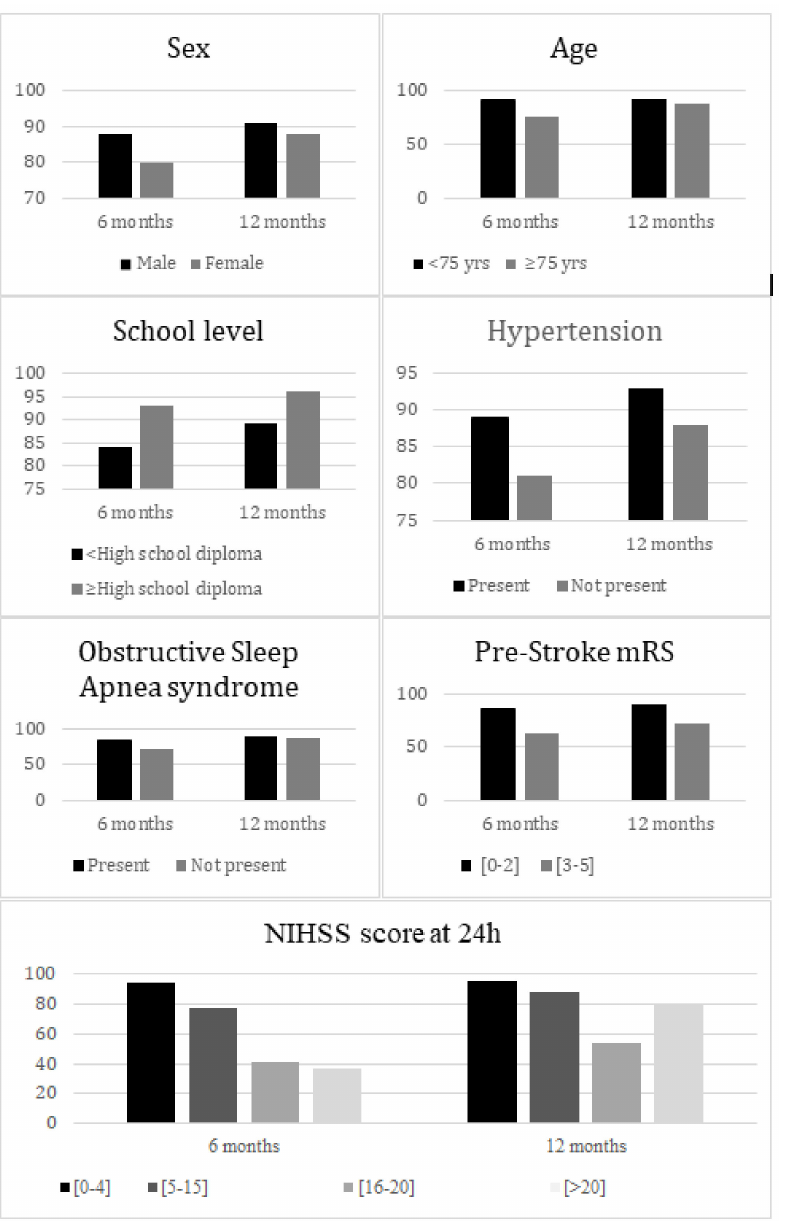
Figure 2. Mean self-care score at 6 months and 12 months according to patients’